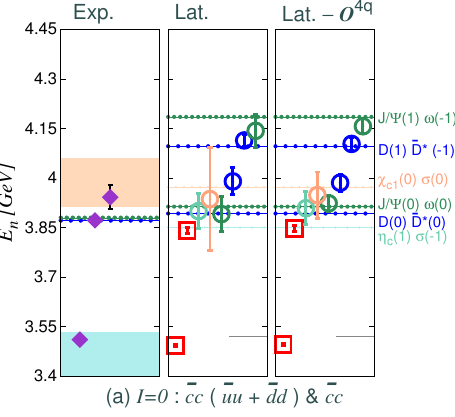
Figure 2. Study of the X (3872) on the lattice [16]. The basis of lattice operators include ¯ cc , two-meson and tetraquark O 4 q